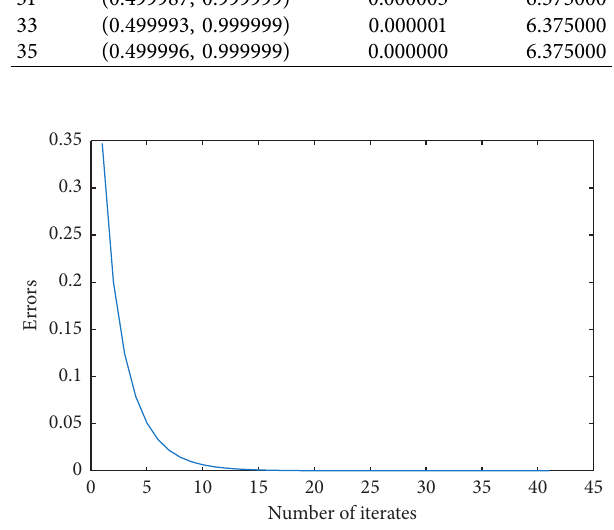
Figure 1: Number of iterations and